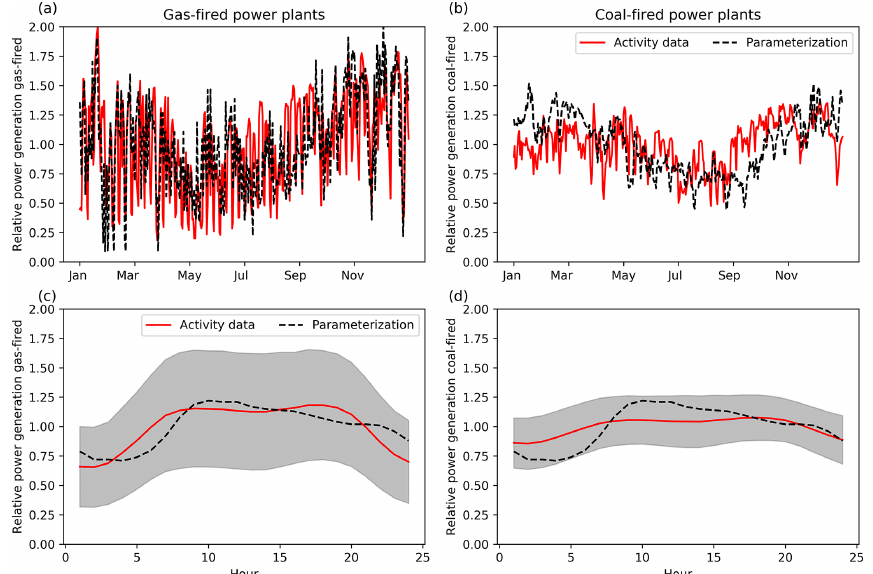
Figure 4. Daily time profiles for gas-fired (a) and coal-fired (b) power plants. Solid red lines are based on true activity data, whereas dashed black lines are parameterizations based on observed temperature (coal) and wind speed and radiation (gas). Average diurnal cycle for gas- fired (c) and coal-fired (d) power plants. Solid red lines are based on true activity data, whereas dashed black lines are fixed profiles from the MACC inventory (Denier van der Gon et al., 2011; Kuenen et al., 2014). Shading gives the 1 σ variability of the diurnal cycle based on activity